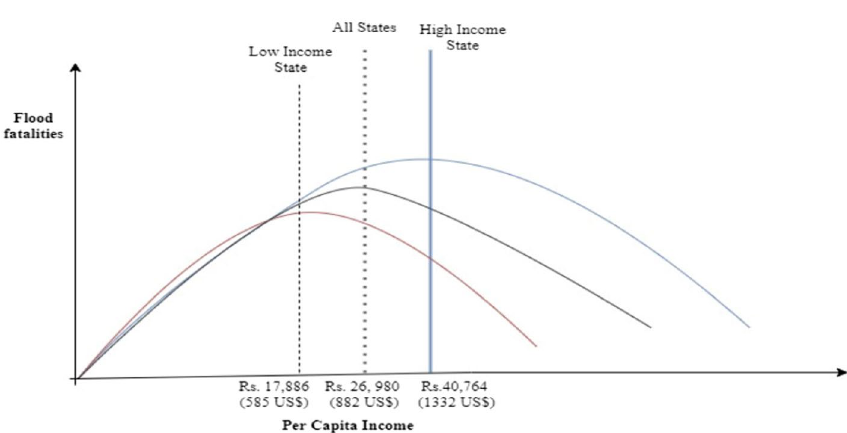
Figure 2. Turning point for flood fatalities with respect to per capita income-all states, high-income, and low- income